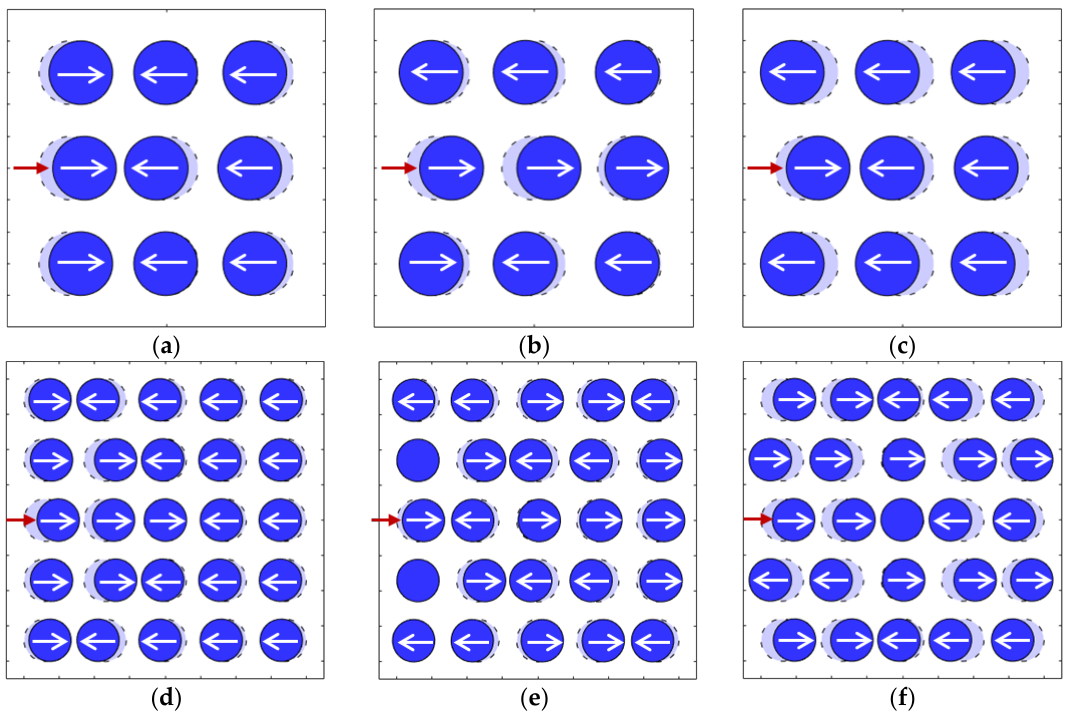
Figure 10. Mode shapes of nuclear fuel rod bundles in the fluid medium: ( a ) N = 9, f = 1.3 Hz; ( b ) 1.6 Hz; ( c ) 2.5 Hz; ( d ) N = 25, f = 1.1 Hz; ( e ) 1.6 Hz; and, ( f ) 9.1